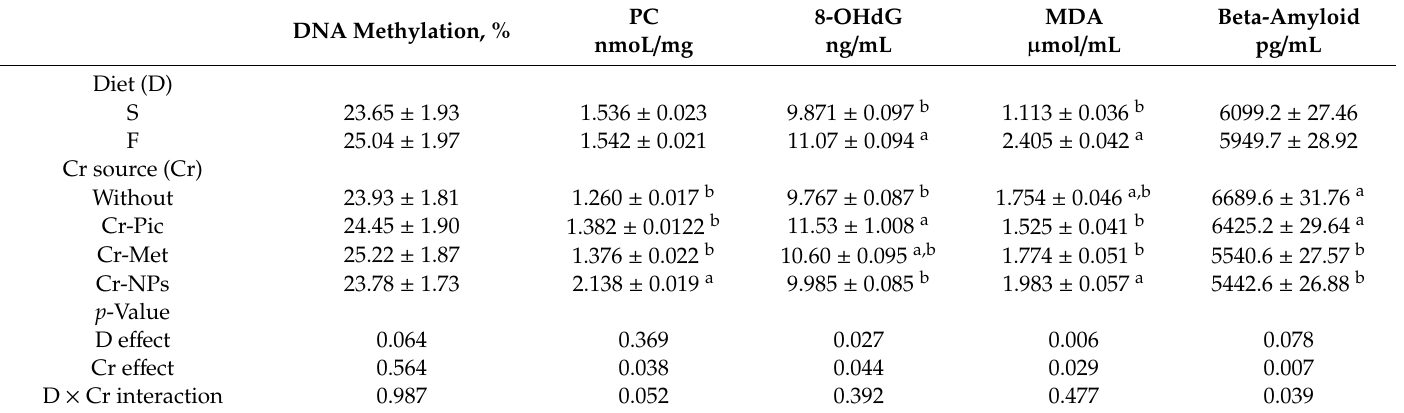
Table 3. DNA methylation, beta-amyloid content, and lipid, protein, and DNA oxidation indicators in rat blood. DNA Methylation,